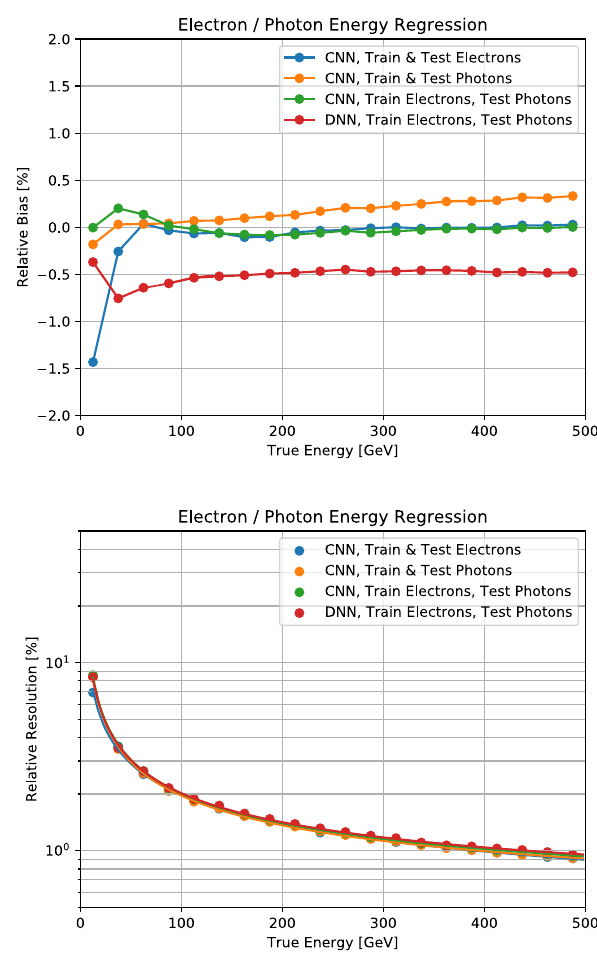
Fig. 35 Regression bias (top) and resolution (bottom) as a function of true energy for all particles, comparing the XGBoost baseline with the best CNN model on fixed-angle samples